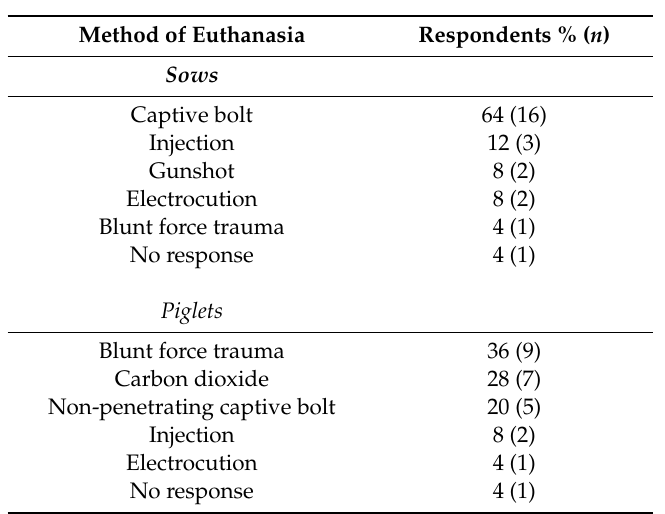
Table 2. Respondent answers when asked to indicate “the most common euthanasia method you use” for sows and piglets ( n = 25). Respondents were asked to fill in the method; no options were